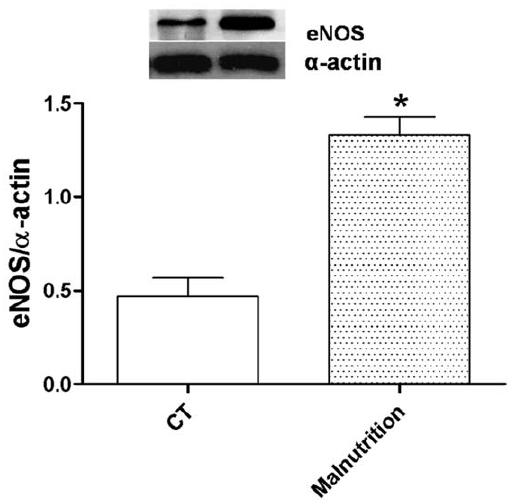
Figure 3. Densitometric analysis of the Western blots for endothelial NO synthase (eNOS) protein expression in the isolated aortic rings from Wistar rats (CT, N=9) and post- weaning protein malnutrition (Malnutrition, N=9). The number of preparations is indicated in parenthesis. Each bar represents means 6 S.E.M as the ratio between the signal for the eNOS protein and the signal for a -actin. * P , 0.05 for CT vs. Malnutrition by Student’s t -test. Representative blots are shown.